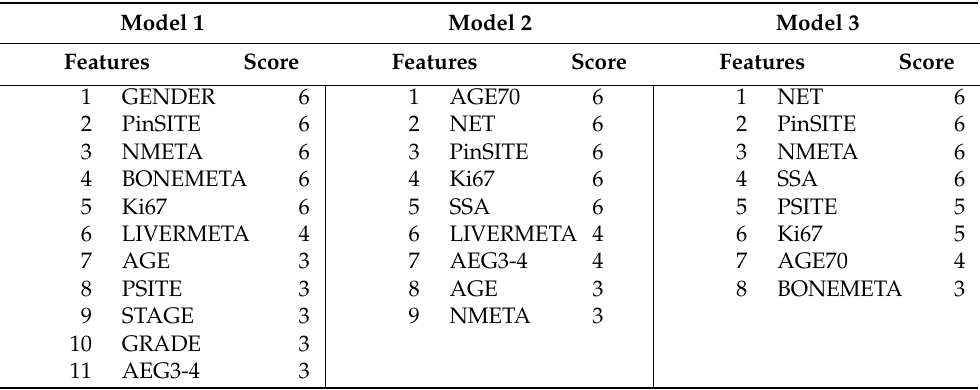
Table 2. Selected features for each model and their